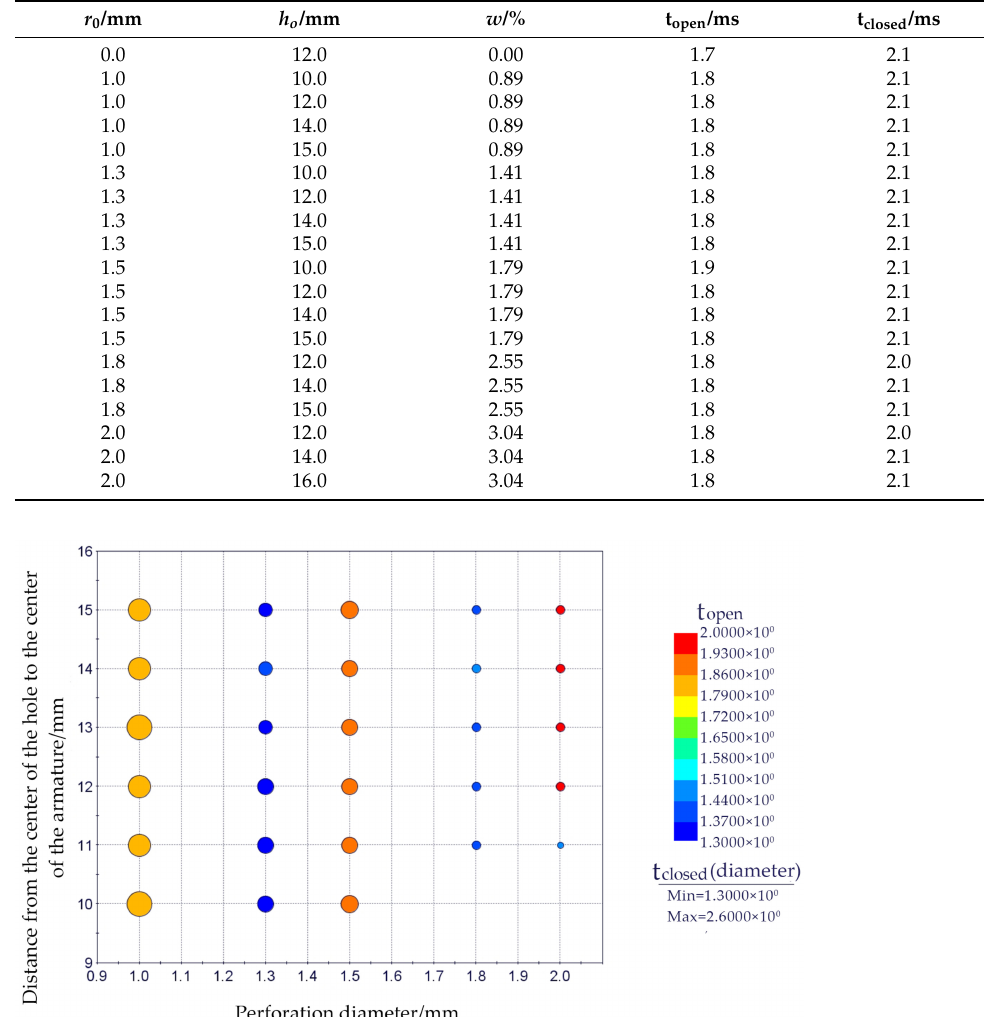
Figure 15. Overall relationship of inter-yoke area perforation. In particular, when h 0 = 13 mm, the solenoid closing response time decreased 33.3% compared to the open, while the opening response increased by only 11.7% and the overall response time decreased by 13.2%, as shown in Figure 16.